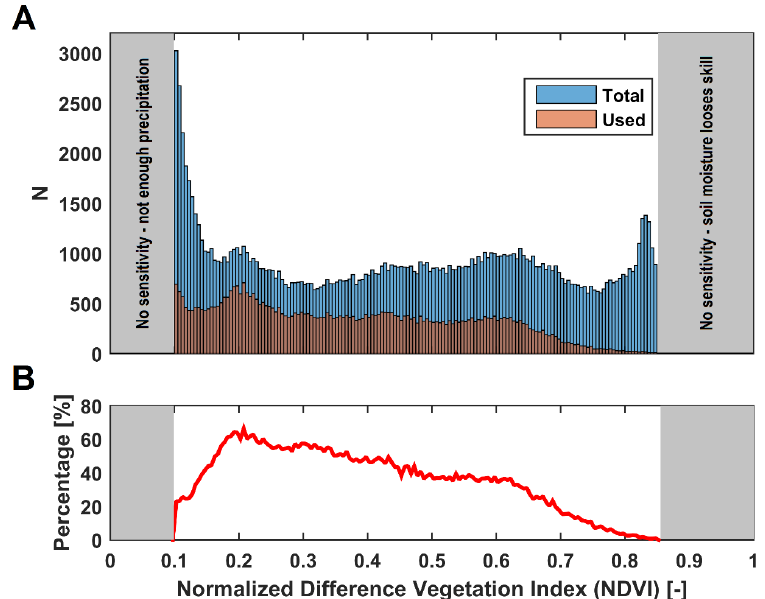
Figure 3. The number of data points used in the evaluation compared to the total amount of points available over our quasi-global study area, divided in NDVI bins with steps of 0.005 ( A ), and the percentage of the used data points within the NDVI binning procedure as compared to the total points ( B